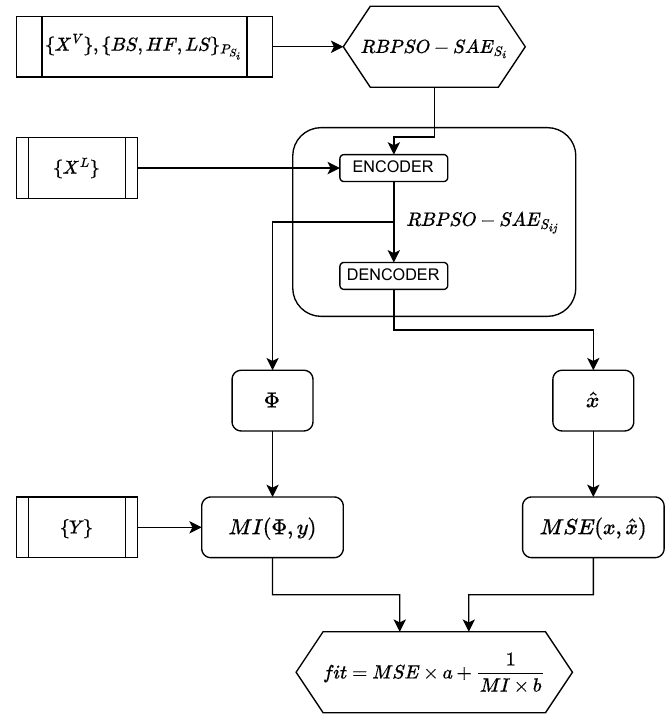
Figure 3. Fitness function